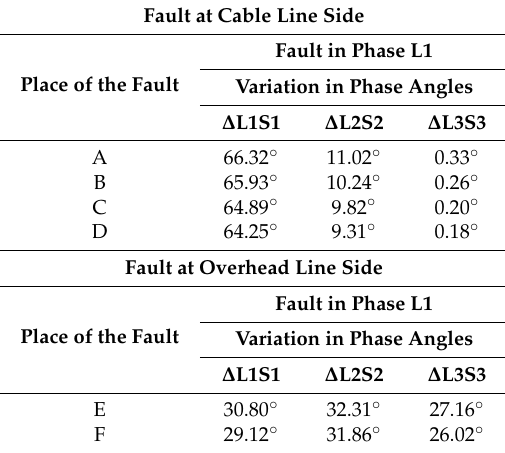
Table 3. Ground fault at overhead and cable line sides in phase L1. Variation in phase angles between currents in the conductors and their respective shields. Fault at Cable Line Side Fault in Phase L1 Place of the Fault